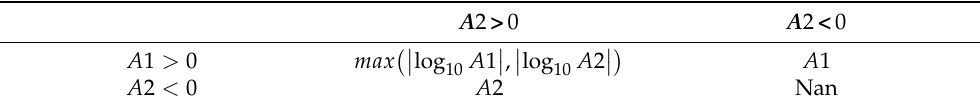
Table 1. A-value selection